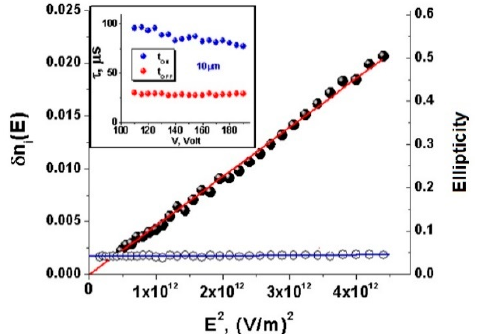
Figure 17. The induced birefringence and the ellipticity of the emerging light of 18 µ m thick VADHF cell at the frequency of 40 Hz [40]. The insertion represents the variation of the switching on and off time with respect to the applied voltage.